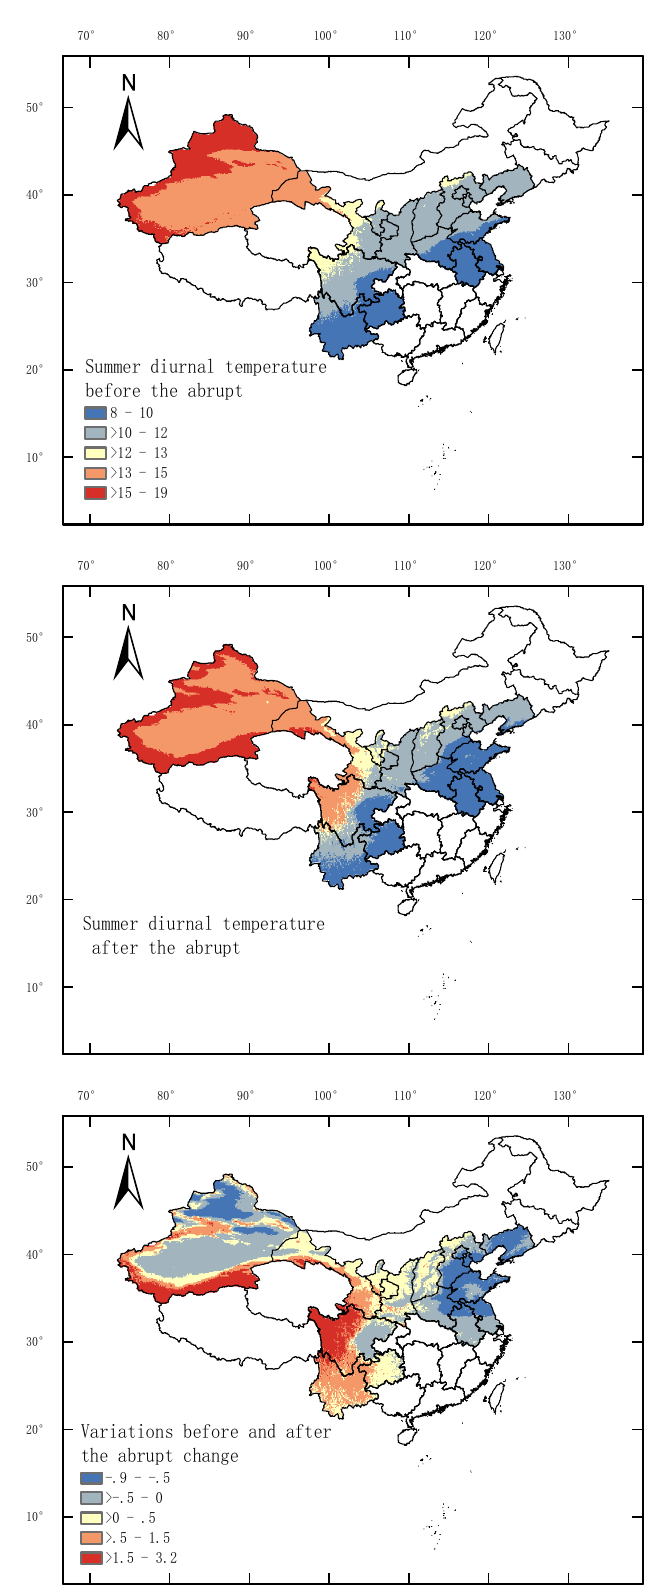
Figure 7. The changes in spatial distribution of the major apple-producing regions in China before and after the abrupt change of average summer diurnal temperature, wherein the yellow area represents the optimal range of average summer diurnal temperature for high-quality apple growing.